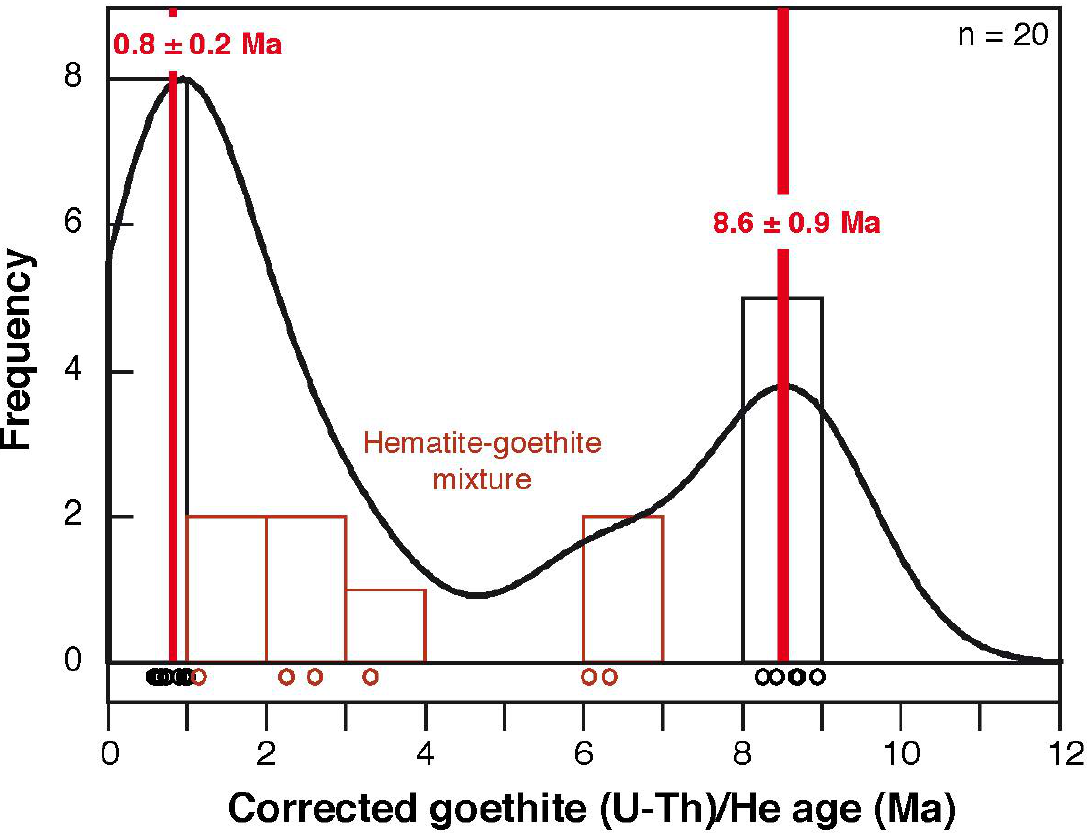
Figure 4. Corrected (U-Th)/He histogram age: supergene goethite in black histogram boxes and black circles (our data); hematite-goethite mixture in brown histogram boxes and brown circles (our data). The two main crystallization phases of supergene goethite at 8.6 ± 0.9 Ma and 0.8 ± 0.2 Ma are also reported in red. For hematite-goethite mixed samples, (U-Th)/He ages range between the two main weathering phases.